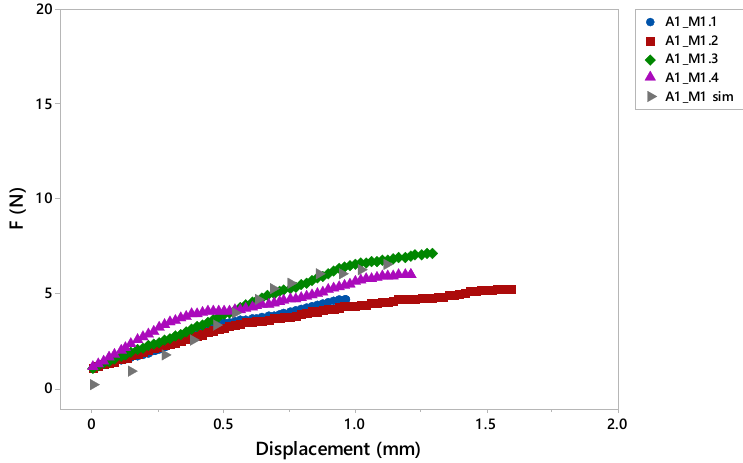
Figure 18. Comparative graph of the results obtained in the compression test by FE.